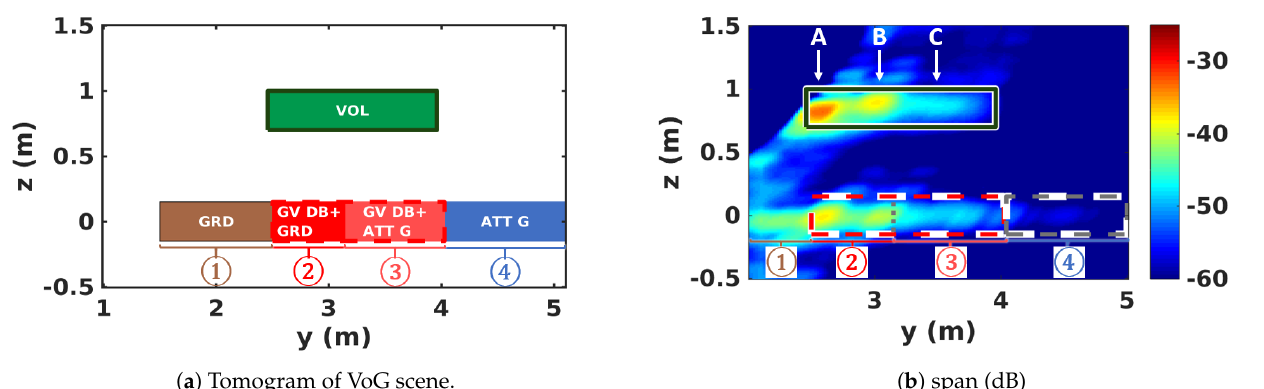
Figure 11. Identification of regions with different scattering features along a tomographic profile, evaluated at the azimuth position x = 0